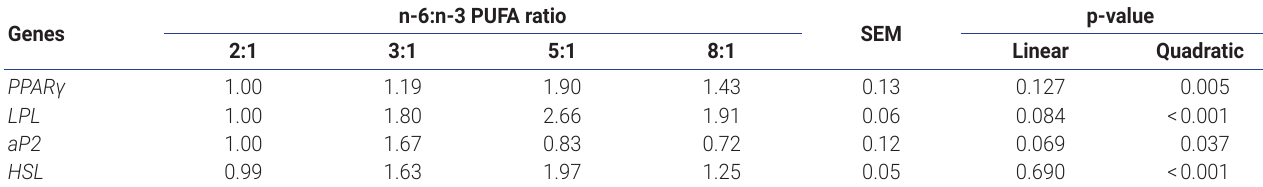
Table 9. Effects of dietary n-6:n-3 PUFA ratios on the relative mRNA expression levels of genes in the SCAT of